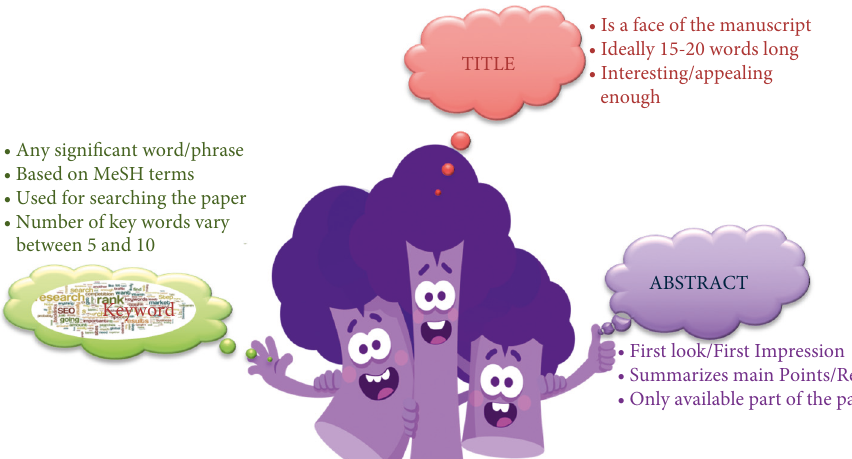
Figure 3: Three important contents of the title page—title, abstract, and keywords. Table 1: Common mistakes authors make in their